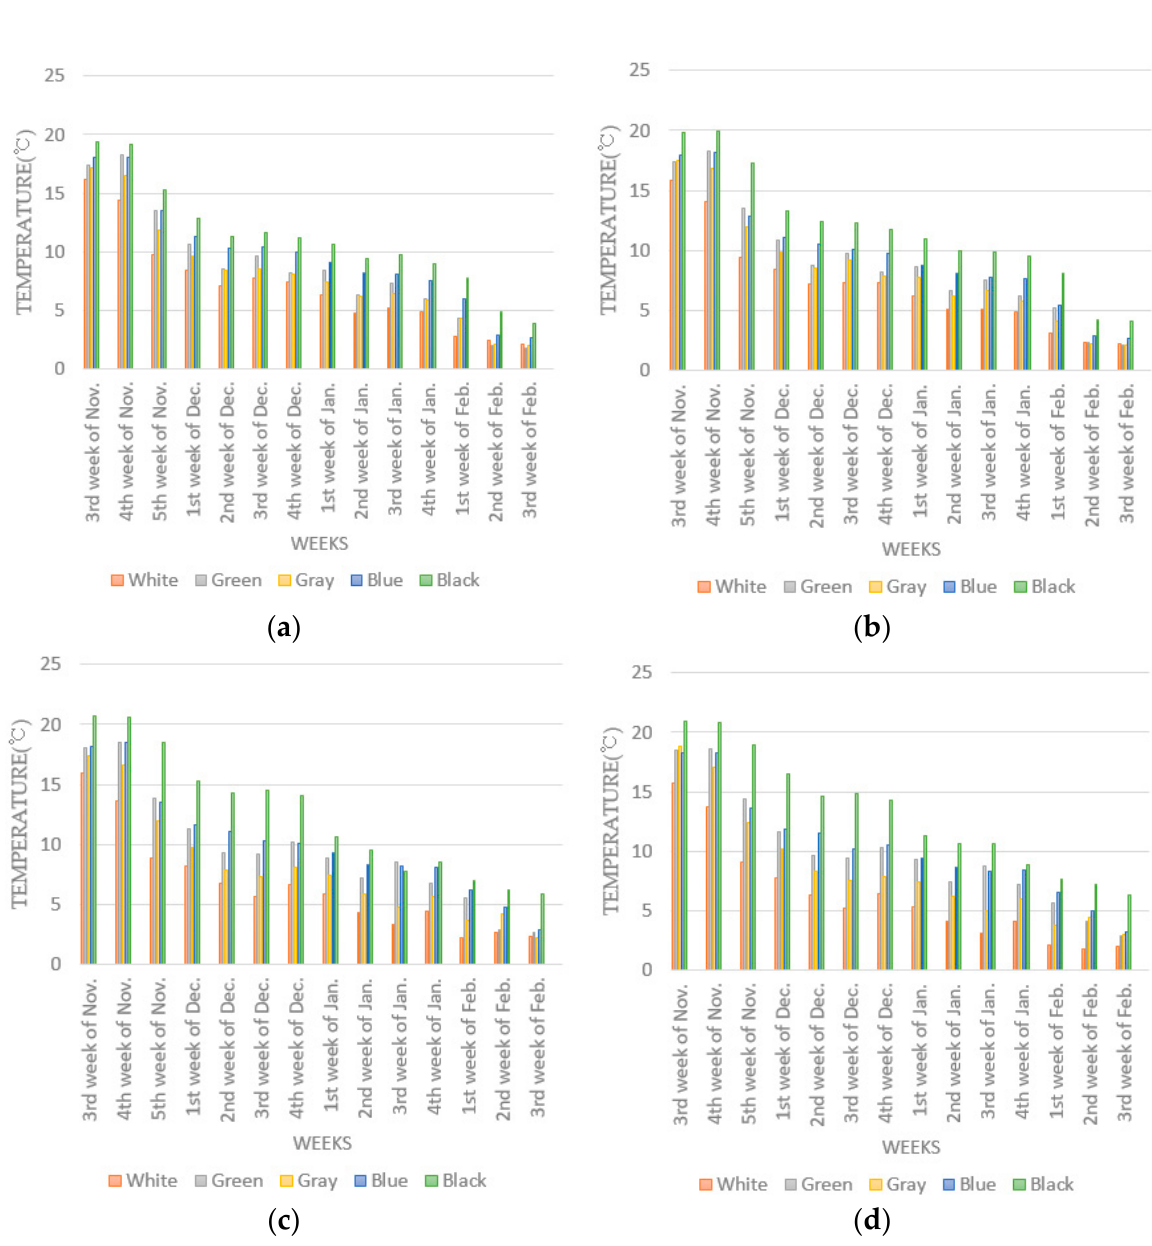
Figure 7. Weekly indoor average temperature acquired by a UAV-mounted TIR camera at different times (The vertical axis is the temperature ( °C ), and the horizontal axis is the weeks.): ( a ) 10h, ( b ) 12h, ( c ) 14h, and ( d ) 16h.